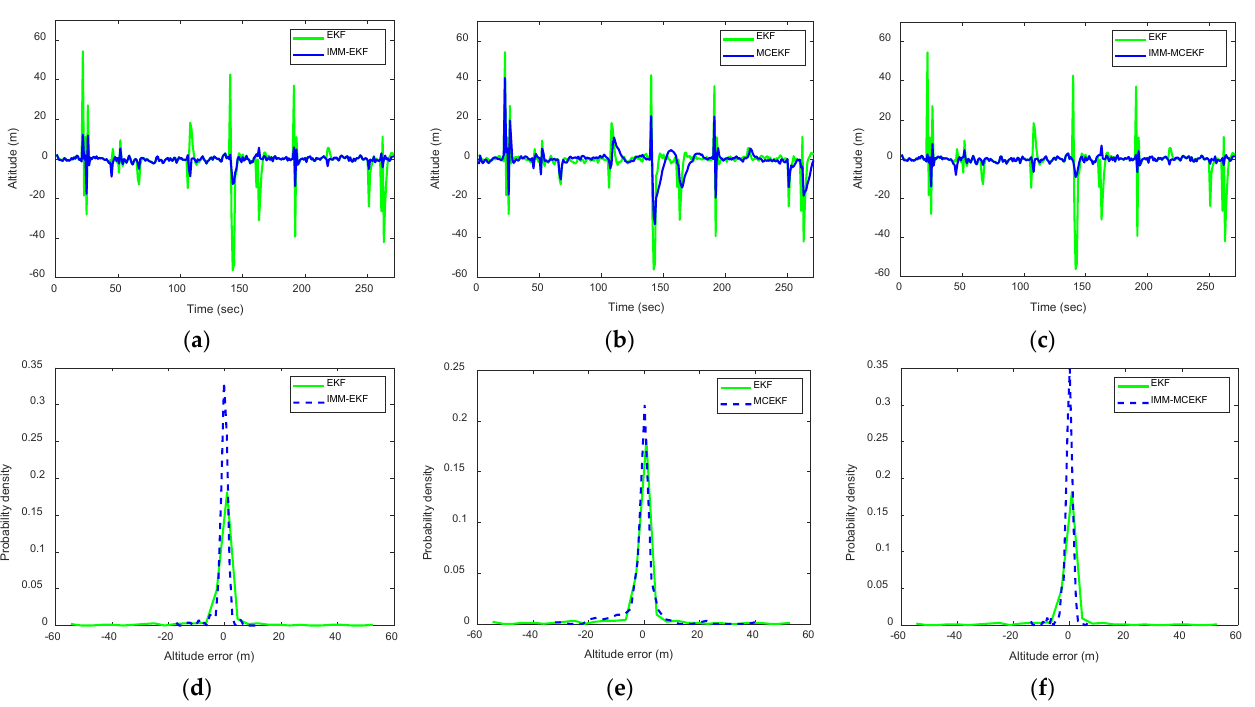
Figure 9. Comparison between the navigational accuracy and the corresponding pdfs of the altitude position errors: ( top ) navigational accuracies for EKF vs. ( a ) IMM–EKF, ( b ) MCEKF, and ( c ) IMM–MCEKF, and ( bottom ) pdfs of position errors for EKF vs. ( d ) IMM–EKF, ( e ) MCEKF, and ( f ) IMM–MCEKF.